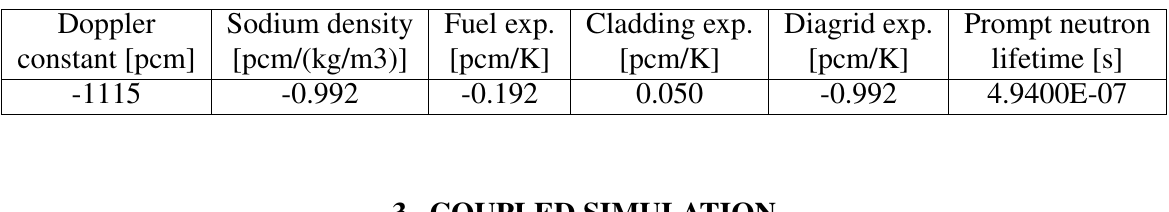
Table 2: Feedback coefficients used in the point kinetic